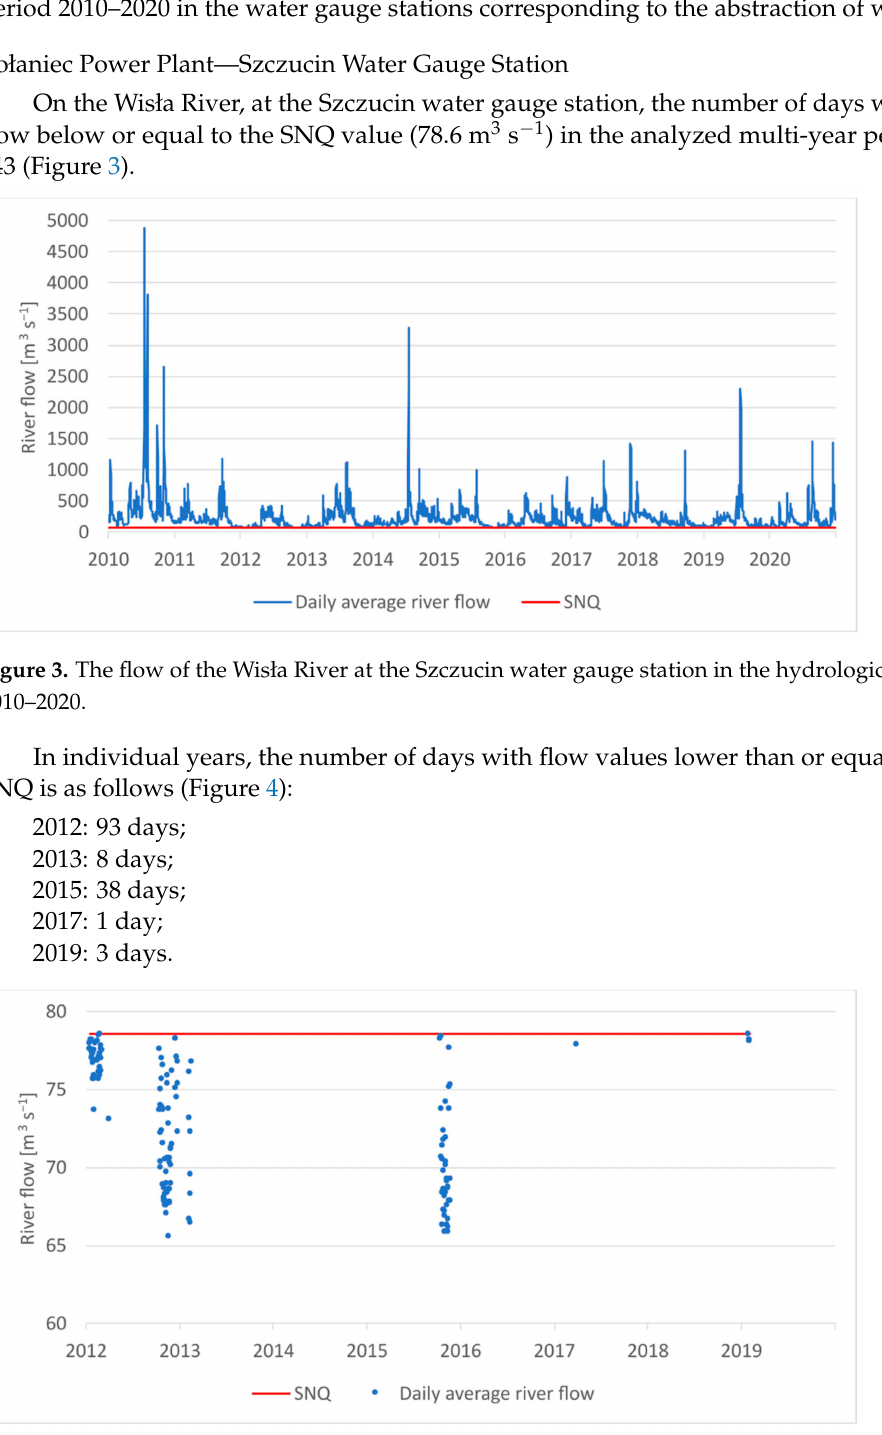
Figure 4. Flow values lower than or equal to the SNQ